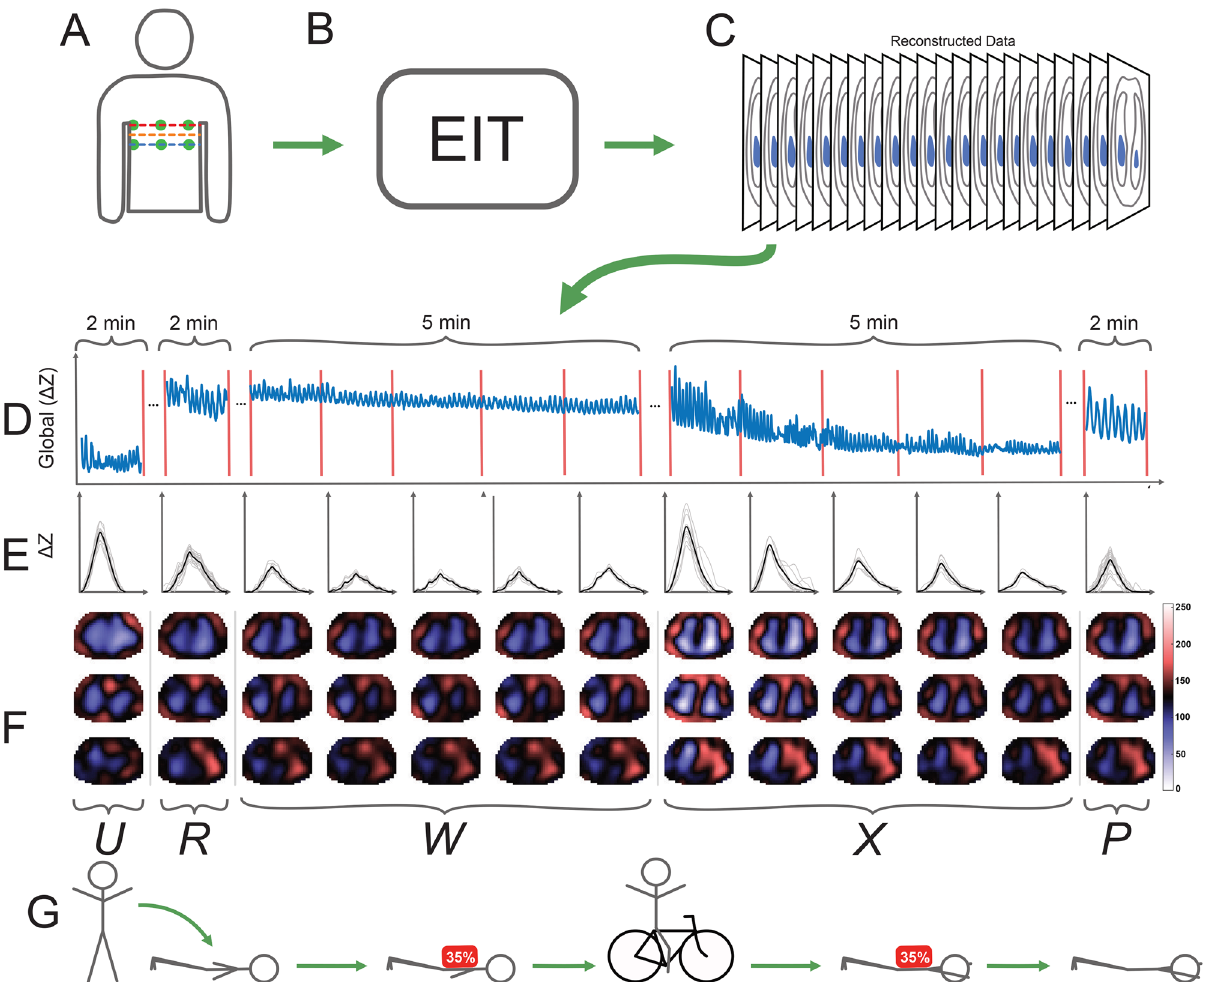
Figure 1. Overview of experimental protocol. ( A ) Two planes of EIT electrodes (2 × 16) were placed on the subject and connected to the SenTec EIT Pioneer Set in a square pattern. ( B ) EIT measurements were recorded for 5 experimental phases: standing upright (U), unweighted prone (R), weighted prone (W), weighted prone in the restraint posture after exercise (X), and unweighted prone in the restraint posture (P). ( C ) Conductivity values reconstructed from voltage data were obtained and used for calculation of parameters. Breath detection was applied on the global sum of (cid:31) Z values of each frame in each phase. ( D ) The global pixel waveform is shown for a sample of each phase (weighted phases were divided into 1-min periods). ( E ) In each phase, breaths were detected (shown as thin lines) from the global (cid:31) Z and the average breath (bold line) was calculated. ( F ) V T images (see text for details) were reconstructed for 3 planes (show in ( A )) using the selected breaths shown in ( E ). ( G ) Schematic of experimental phases. The strenuous bicycle exercise task ( ≤ 10 min) is illustrated between phases W and X. ( A , B , C , G ) were drawn using Inkscape v1.0 (https:// inksc ape. org). ( D – F ) were generated in MATLAB2019a using the EIDORS software package 16